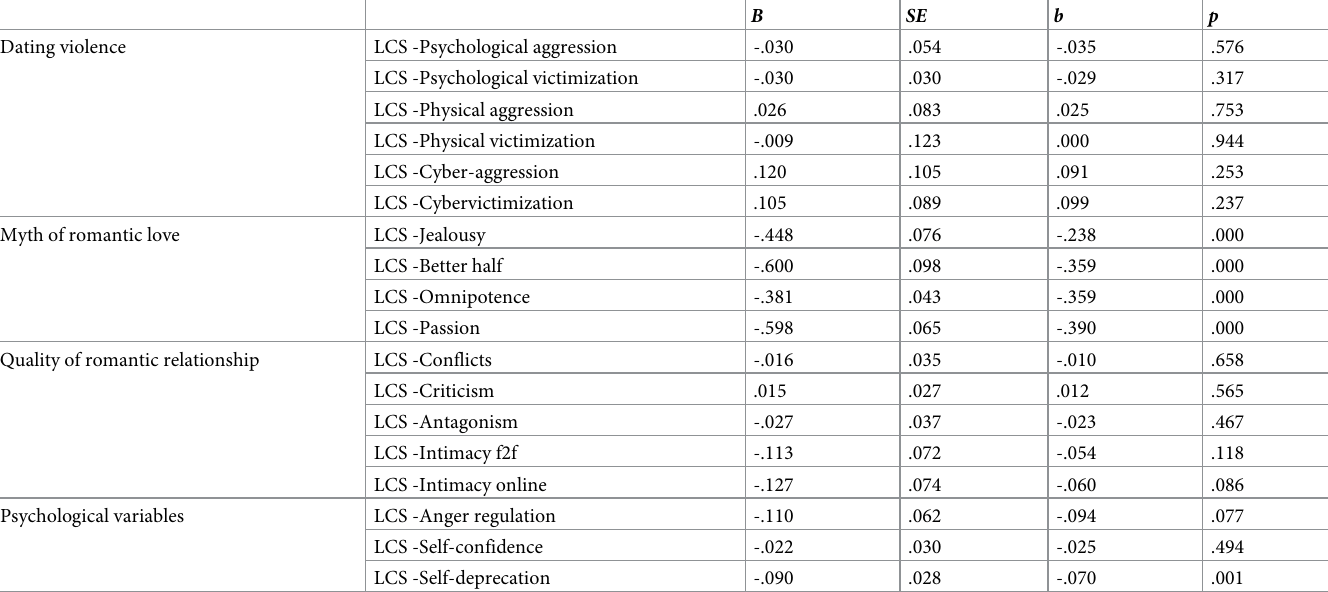
Table 7. Effects of the intervention on outcomes.